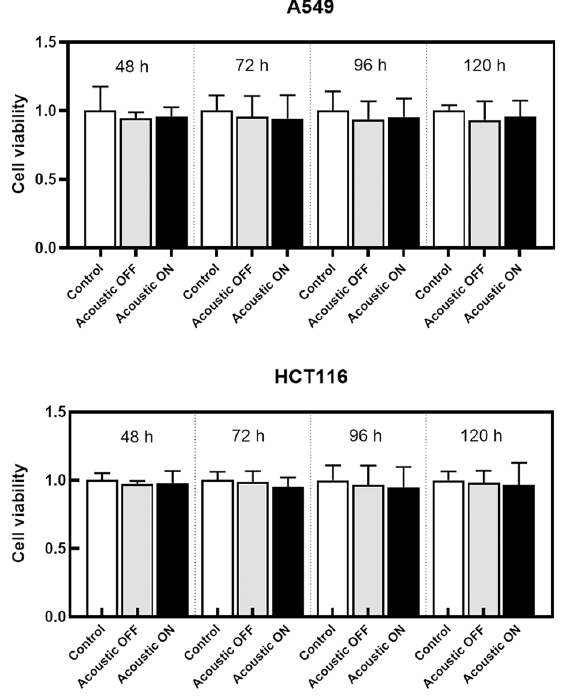
Figure 5. Cell viability at different times after separation. The cell viability of the acoustic-OFF group (gray) and the acoustic-ON group (black) was normalized with the control group (white).